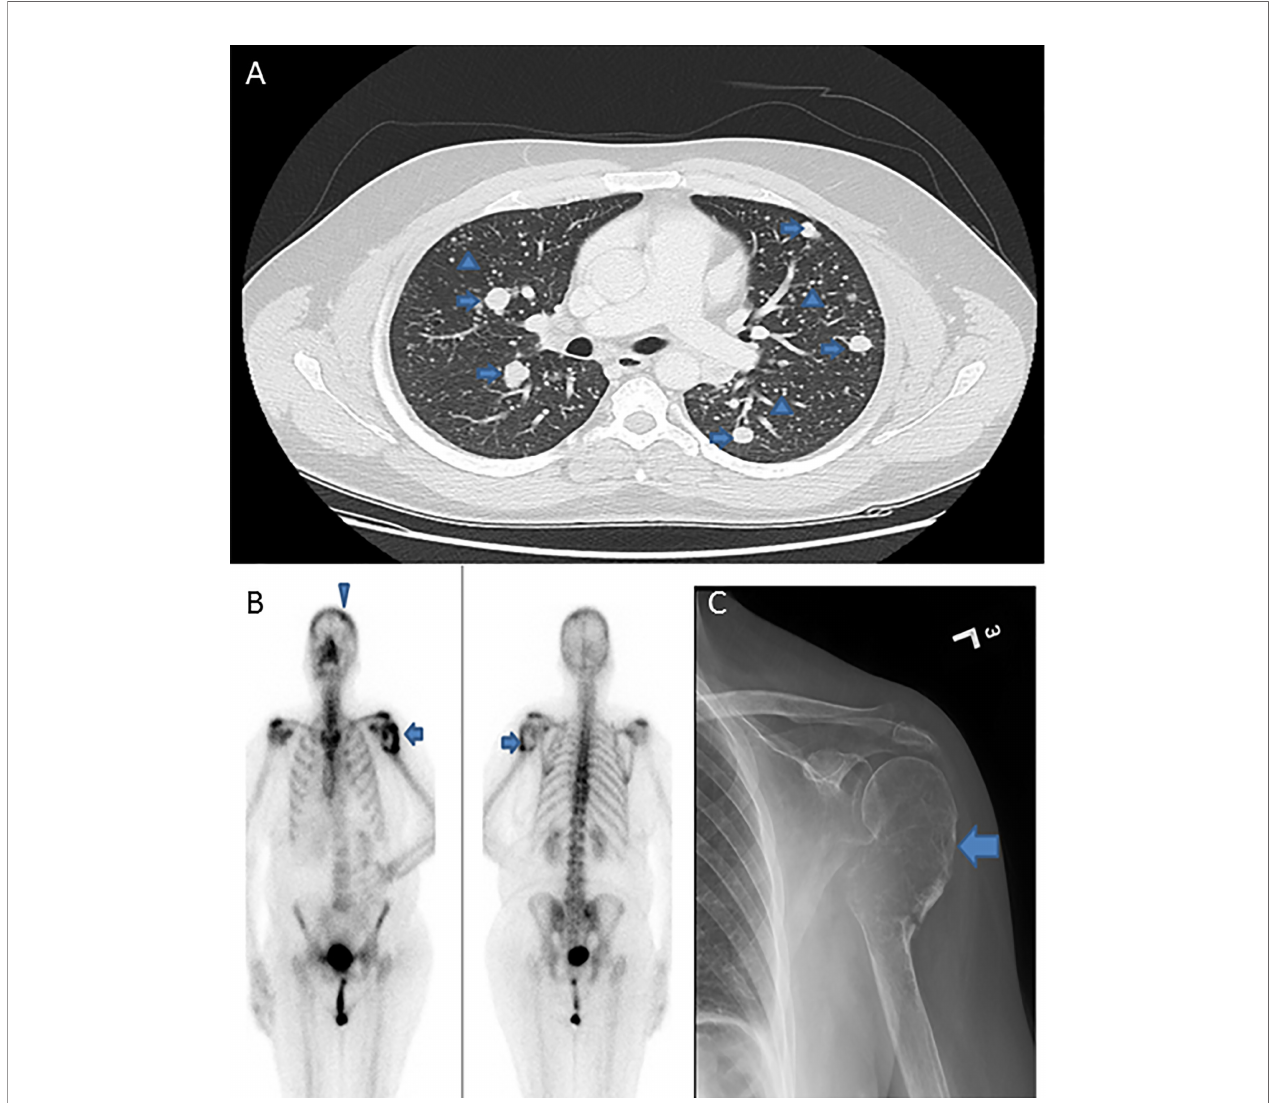
FIGURE 1 | Radiologic images of distant metastasis in papillary thyroid microcarcinoma cases. (A) Computed tomography of the lung showing extensive pulmonary metastases with classic canon-ball metastases (arrows) and miliary metastatic nodules (arrow heads). (B) Positron emission tomography (PET) scan and (C) X-ray, showing expansile lytic metastatic lesion in the left humerus (arrows) with pathologic fracture related to metastasis. PET scan also shows a metastatic focus in the skull bone (arrow